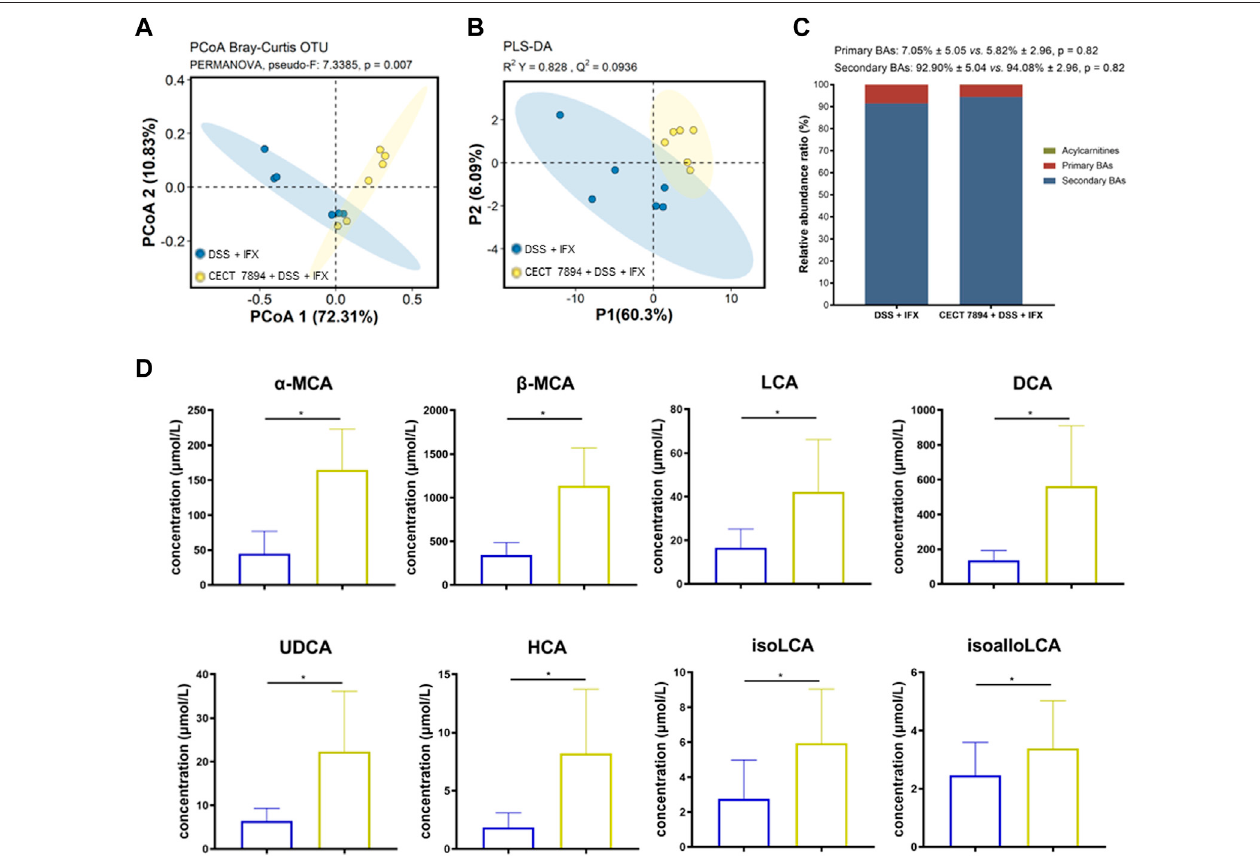
FIGURE6| B.longum CECT7894modulates thefecalBAslevels. (A) PCoA plotbasedonBray-Curtisdistance offecalBAsbetweentheDSS+IFX groupand B. longum CECT 7894 + DSS + IFX group. (B) PLS-DA models discriminated fecal metabolites between the DSS + IFX group and B. longum CECT 7894 + DSS + IFX group. (C) Relative abundance ratio of different BAs. (D) Bar charts showing representatively changed fecal BAs between the DSS + IFX group and B. longum CECT 7894 + DSS + IFX group. Data were presented as mean ± SD. Signi fi cance is determined by using the Wilcoxon rank-sum test., with * p < 0.05.